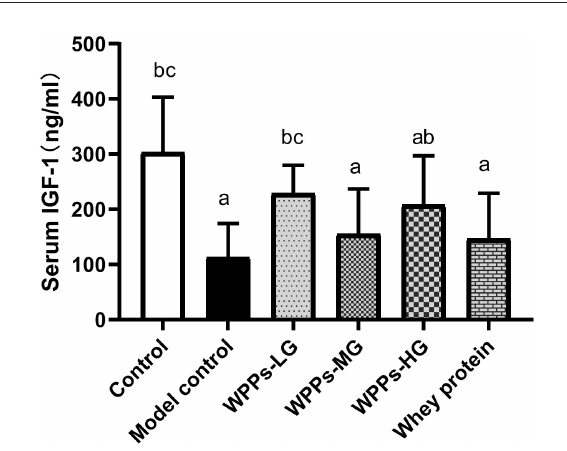
FIGURE4 Effects of WPPs on serum IGF-1. Data are expressed as means ± SD ( n = 8). a p < 0.05 indicates significant difference vs. the control group; b p < 0.05 indicates significant difference vs. the model group; c p < 0.05 indicates significant difference vs. the whey protein group. Whey protein group at a dose of 1.5 g/kg; WPPs-LG, whey protein peptides low-dose group at a dose of 0.3 g/kg; WPPs-MG, whey protein peptides medium-dose group at a dose of 1.5 g/kg; WPPs-HG, whey protein peptides high-dose group at a dose of 3.0 g/kg.